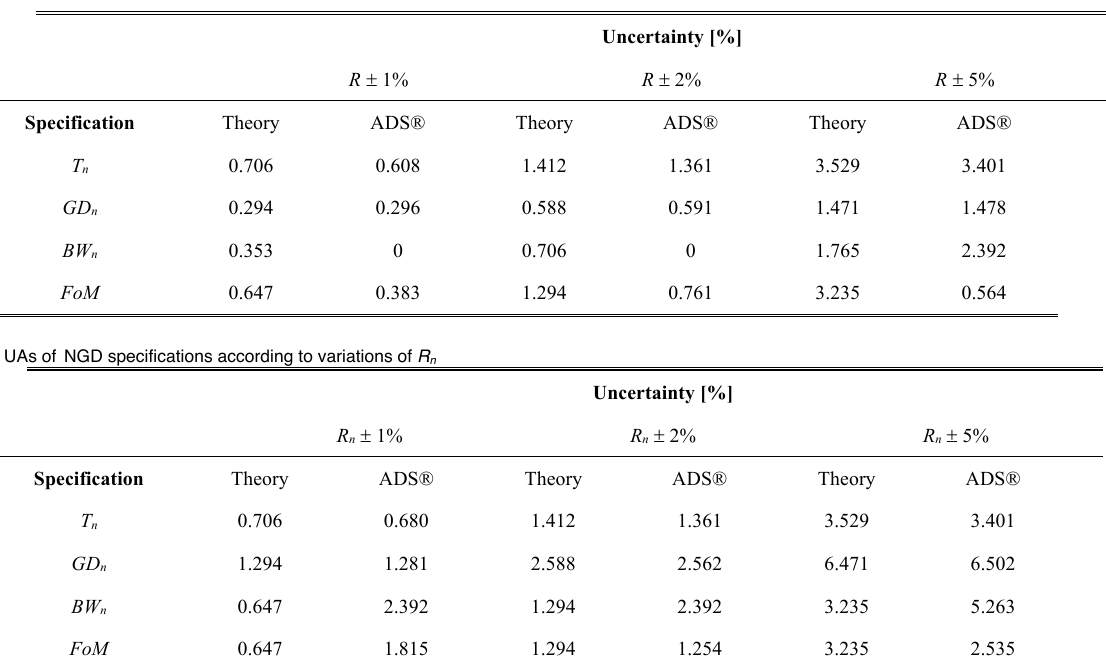
TABLE IV. UAs of NGD specifications according to variations of R